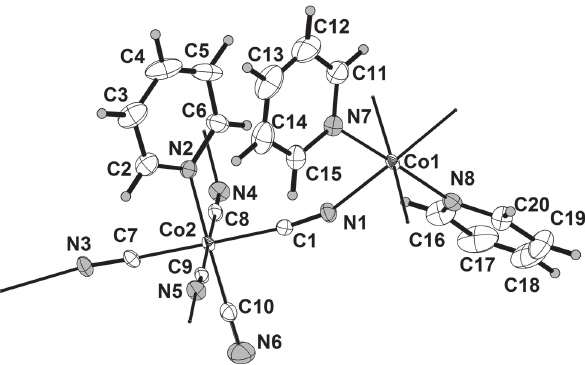
Table 1: Data collection and